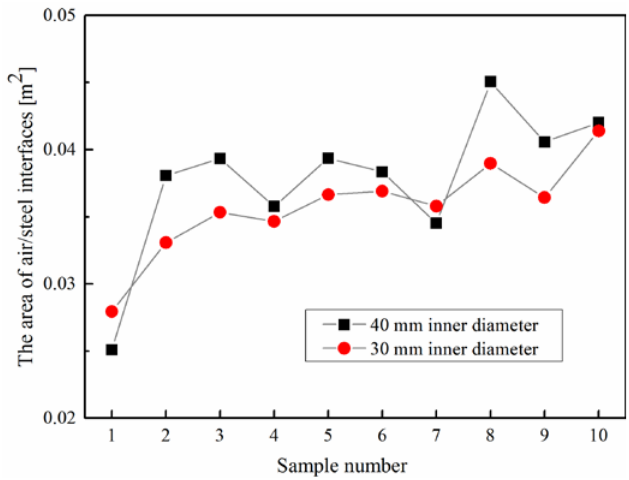
Figure 11. Overall area of air/steel interfaces in varied nozzle inner diameters.